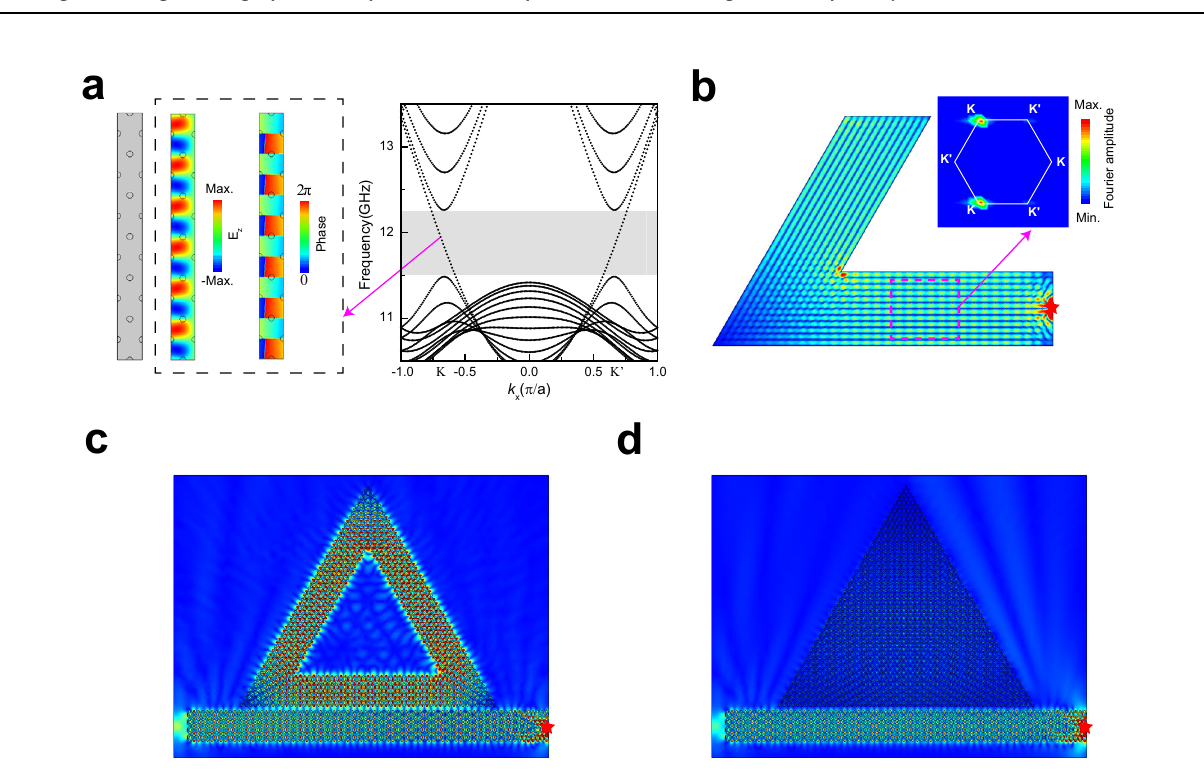
of the acoustic fi eld in the magenta dashed rectangle. b The black squares and red circle represent the experimentally measured intensity pro fi les along the red dot- ted lines in Figs. 2b, 5a, respectively.